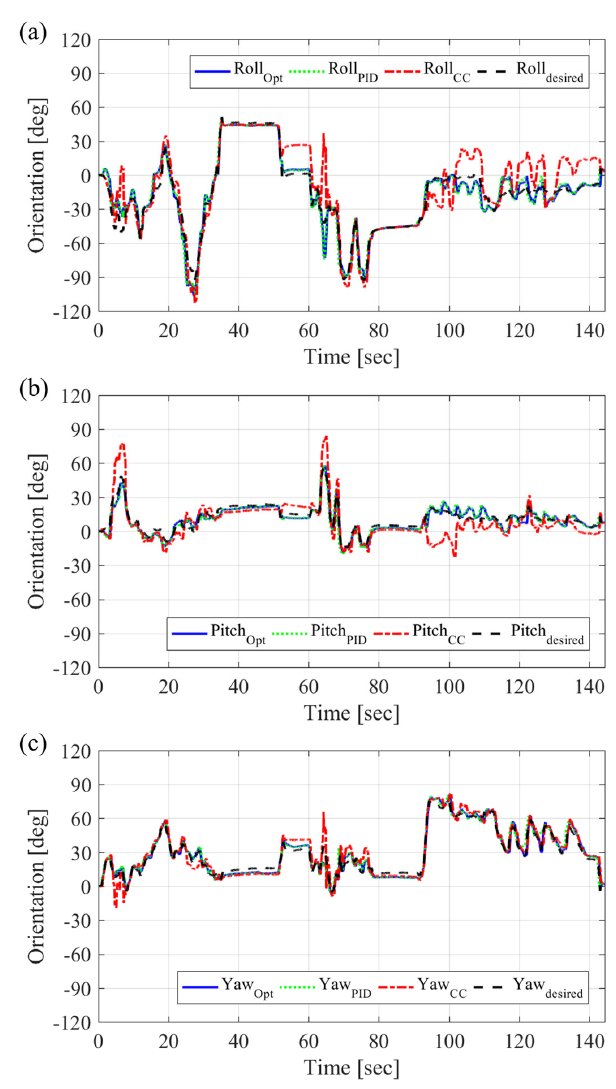
Figure 21. Experimental results of the end ‐ effector’s orientation under the proposed path generators with the kinematic model and the constant curvature model: ( a ) roll; ( b ) pitch; ( c ) yaw.